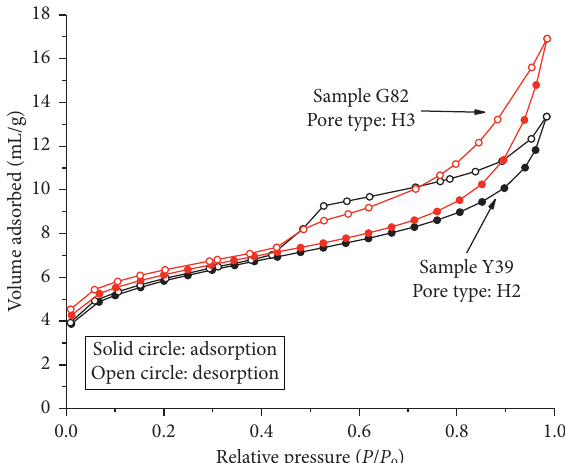
Figure 5: Adsorption/desorption curves of low-temperature (77K) N 2